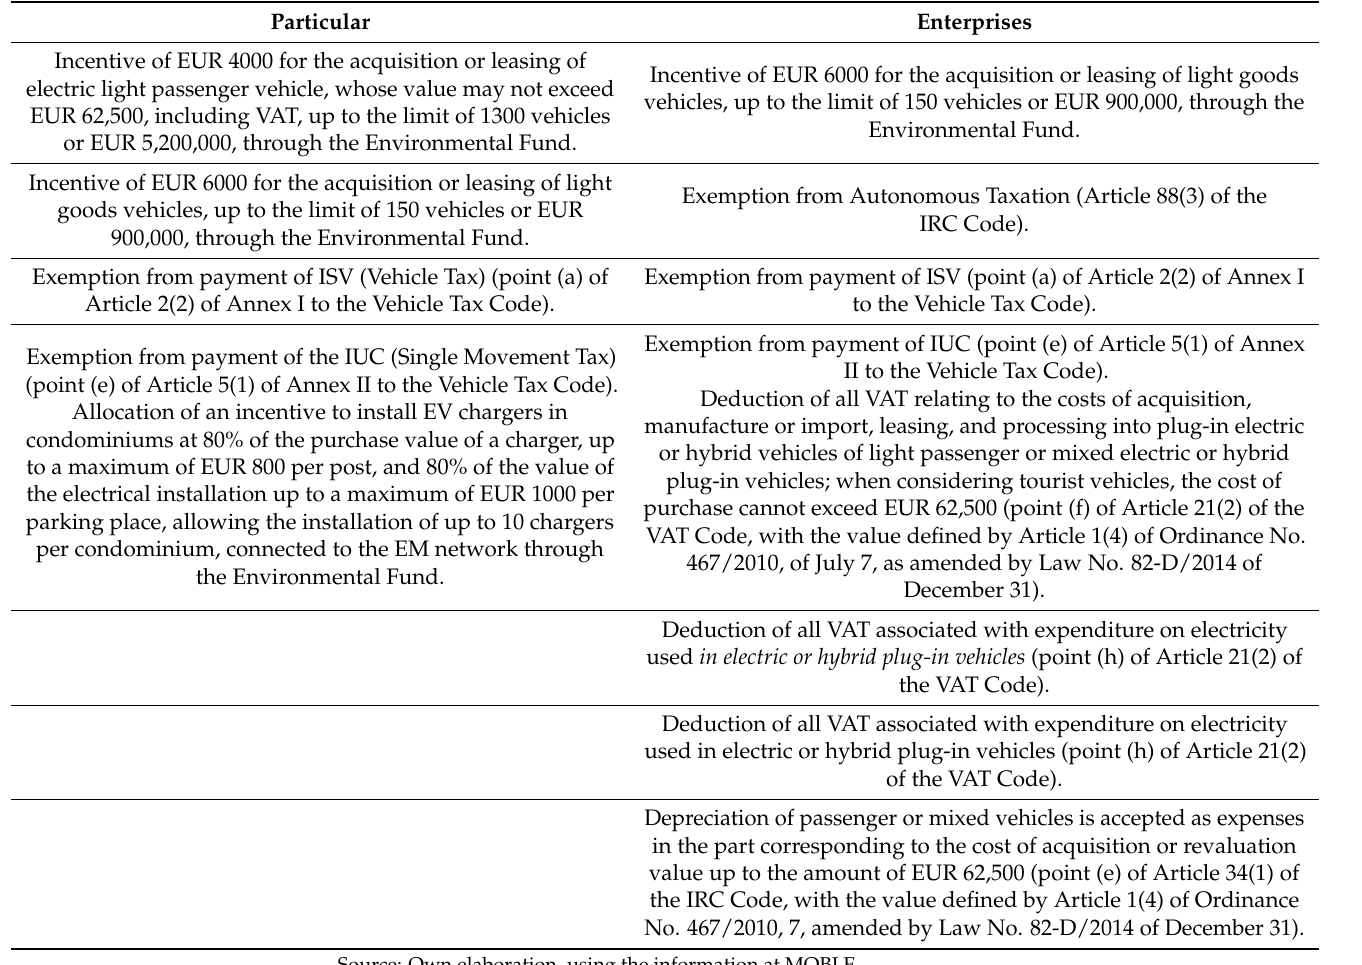
Table 2. Incentives and tax benefits associated with 100% electric vehicles in force in Portugal